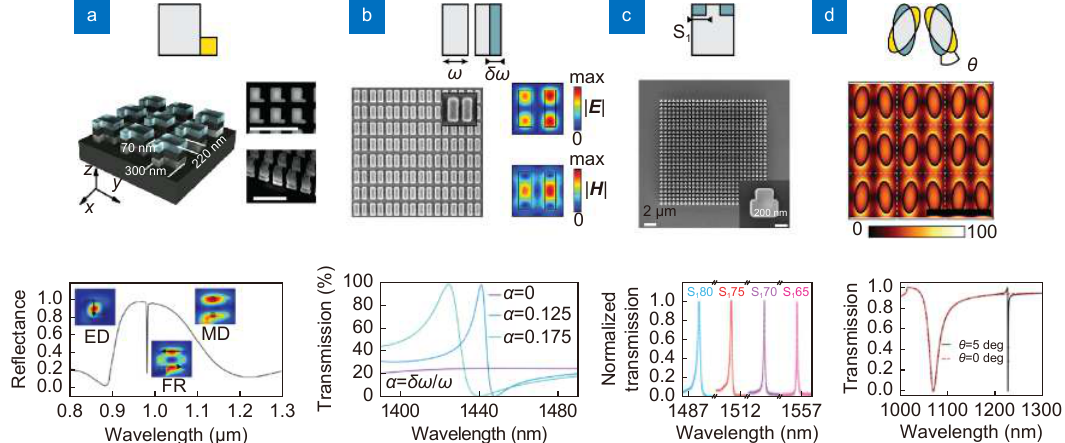
Fig. 5 | Quasi-BIC mode generation in nonlinear metasurfaces. A few ways to break the symmetry and reveal the high-Q resonance are sketched in the top row. Yellow (blue) color denotes a material addition (removal). ( a ) L-shaped GaAs/AlGaO heterostructures 124 . ( b ) Asymmetric Si nanodimers made of two rods with different widths 125 . ( c ) T-shaped Si resonators 126 . ( d ) Asymmetric GaP nanodimers made of two elliptical- basis cylinders rotated by an angle θ 127